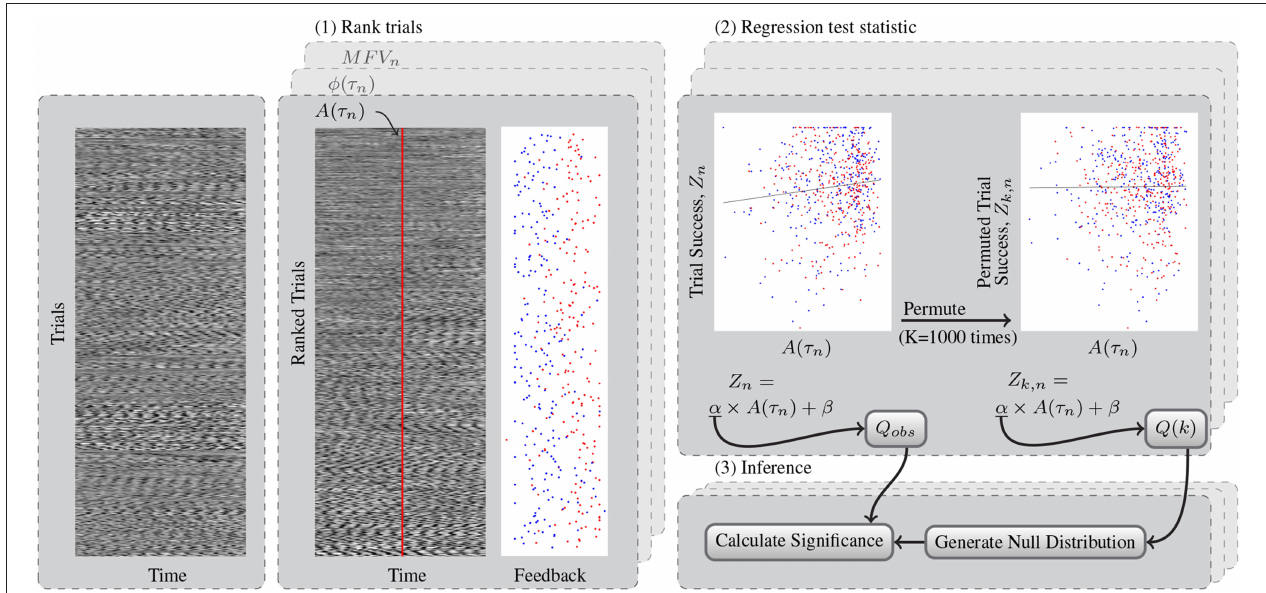
FIGURE 4 | This flowchart shows a generic example of the permutation test for determining significant relationships between gating variables and trial success. (1) Test data from left and right trials are sorted using the rankings determined by each gating method. Shown here, the trials are ranked according to mu amplitude at the time of the cue, A ( τ n ) . Trials with high A ( τ n ) are shown on the bottom of the block. The feedback at the end of these trials is also shown, with left trials in blue and right trials in red. Feedback was subsequently simplified to trial success, Z . (2) The observed test statistic, Q obs is the slope of the regression that relates mu amplitude to trial success. The permuted test statistic Q ( k ) was computed K = 1000 times after permuting the success scores of the trials to Z k , n . (3) The k th value for the maximum and minimum null distributions Q max and Q min were found from Q ( k ) across both channels tested. Finally the p -value of the test statistic distribution is computed as the percentage of values in this null distribution exceeding that of the observed test